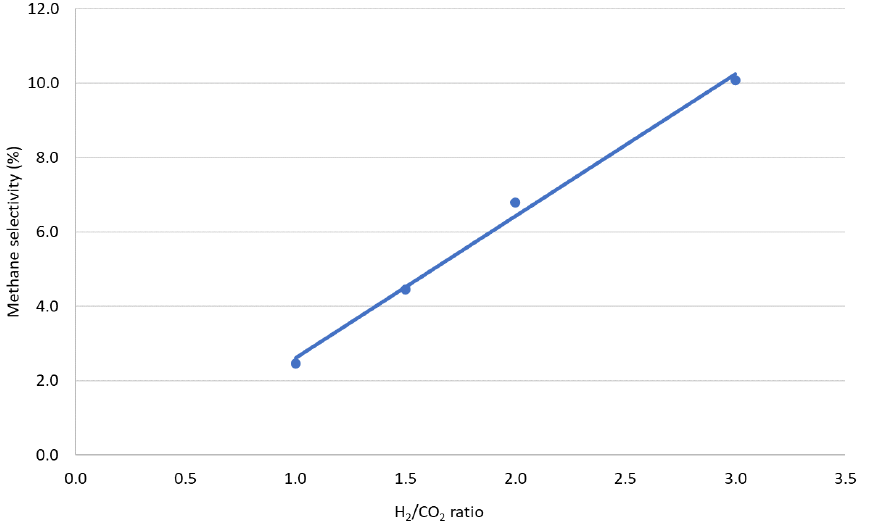
Figure 5. RWGS methane selectivity as a function of the inlet H 2 /CO 2 ratio. GHSV: 35,800 h −1 ; pressure: 6 bar; temperature: 850 °C.